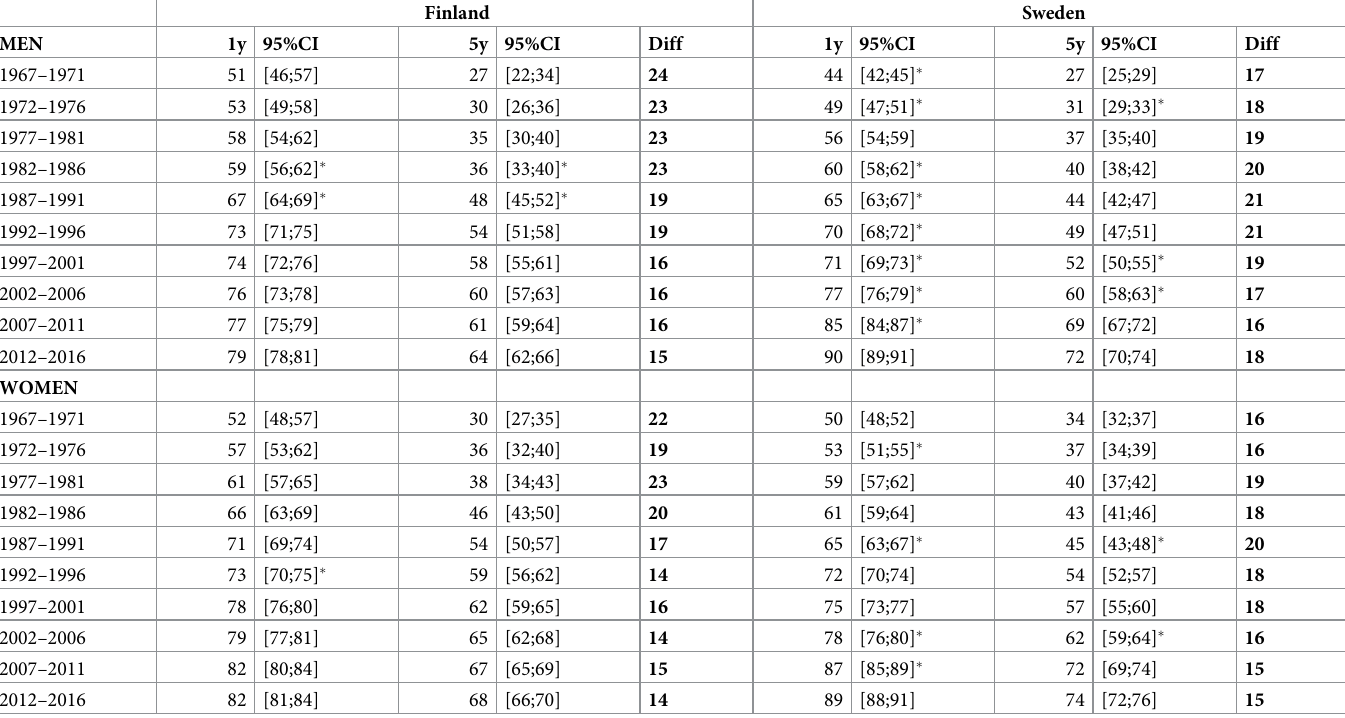
Table 1. Relative 1-year and 5-year survival (%) and their Difference (Diff) in Finland and